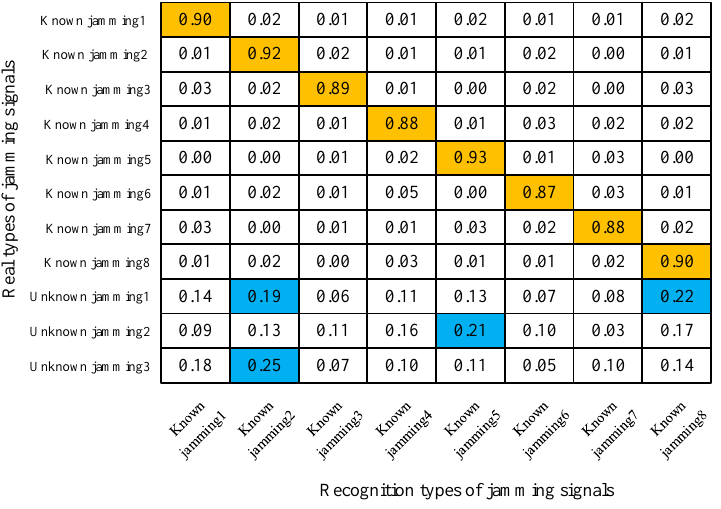
Figure 15. Recognition results of model based on close set CNN model.